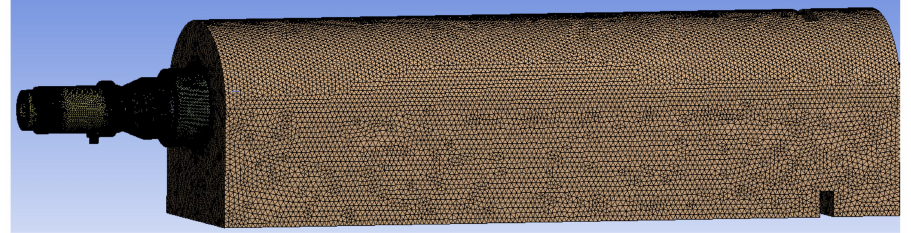
Figure 4. Overall grid diagram of burner numerical simulation